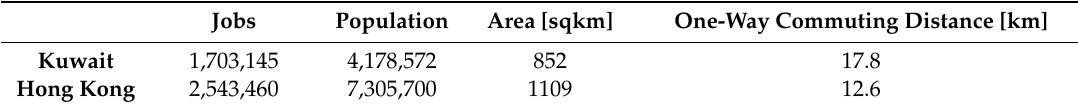
Table 5. Metropolitan accessibility for travel to work.